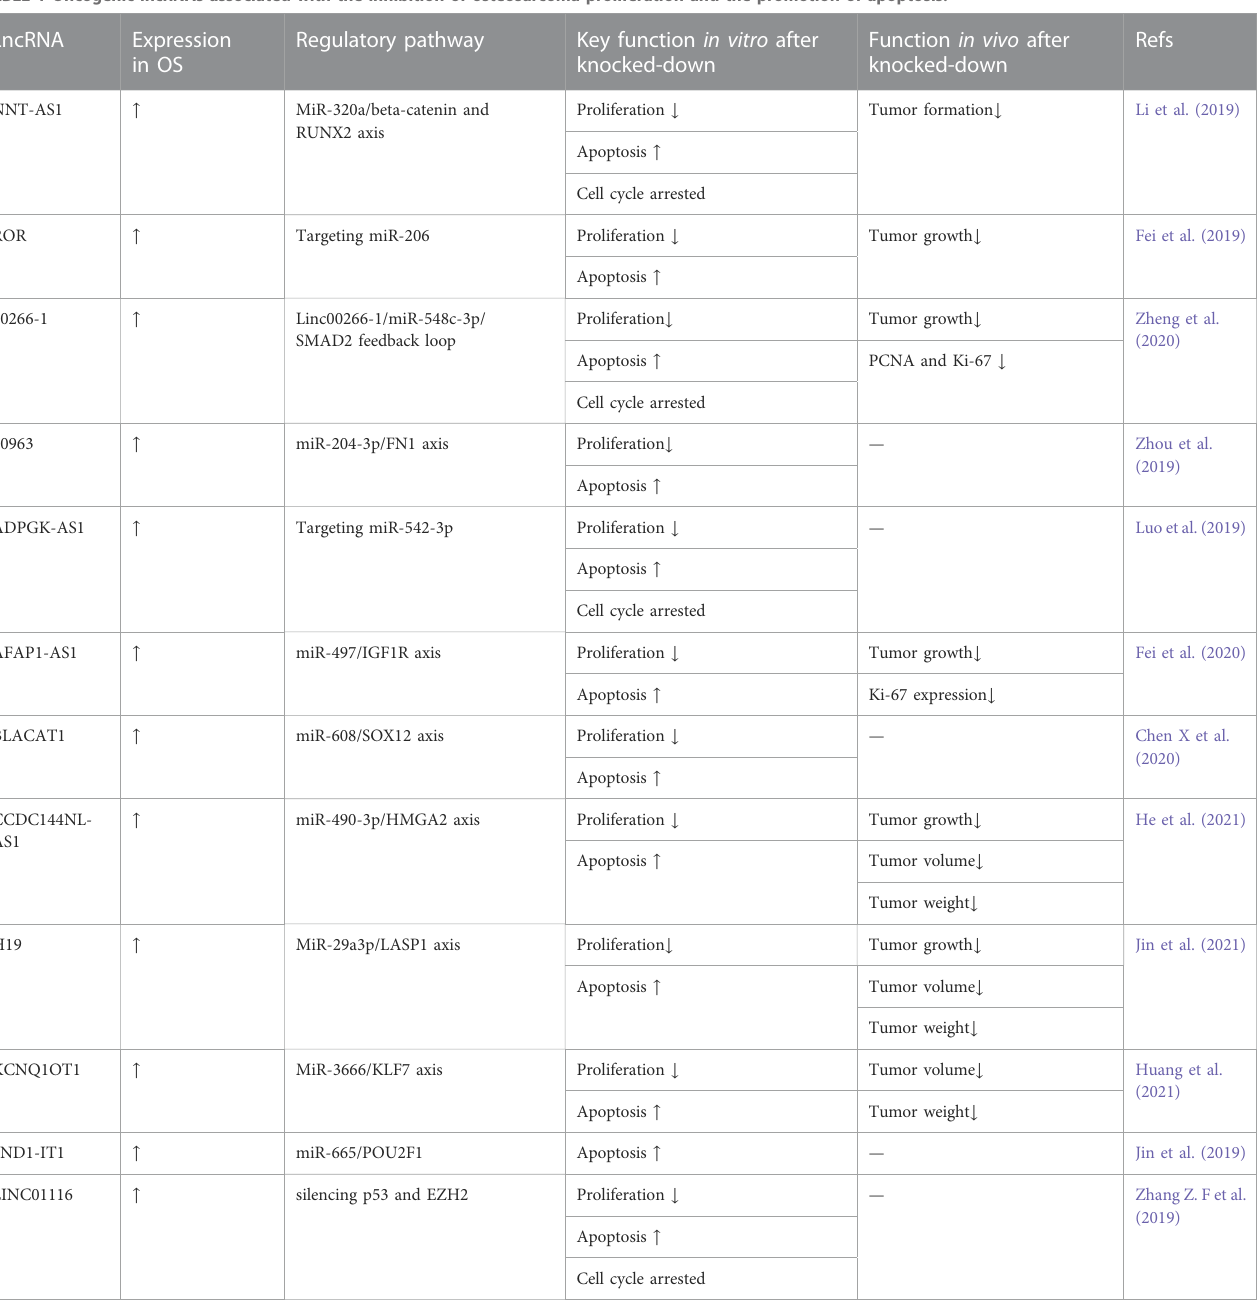
TABLE 1 Oncogenic lncRNAs associated with the inhibition of osteosarcoma proliferation and the promotion of apoptosis.